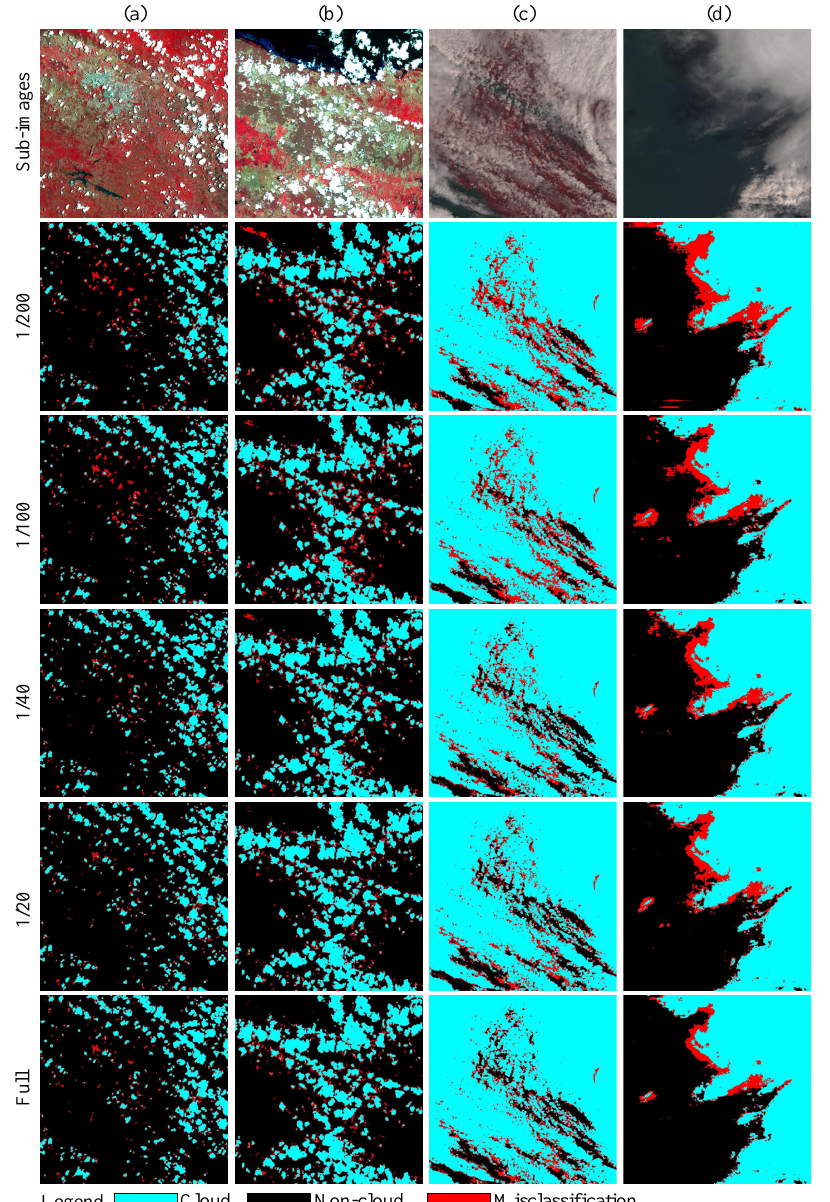
Legend MisclassificationNon-cloudCloud Figure 13. Cloud extraction results (1200 × 1200) of SSCDnet on GF-1 WFV and Landsat-8 OLI data under different labeled sample proportions. ( a , b ) are the results of GF-1 WFV data (GF1_WFV2_W70.8_N19.2_20140801_L2A0000292230), while ( c , d ) are the results of Landsat-8 OLI data